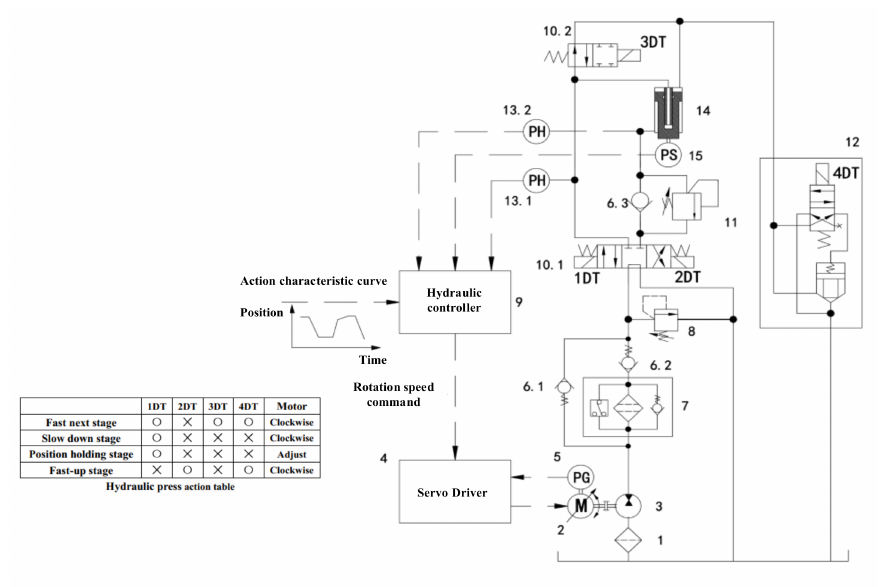
Figure 1. The principle of